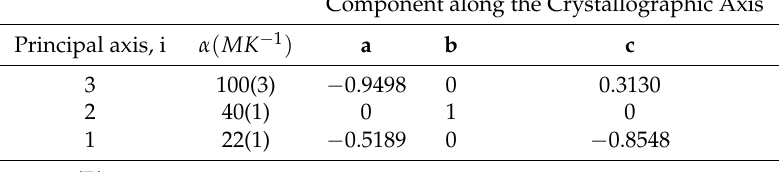
Table 2. The temperature (A) and pressure-induced strains: based on experimental data (B) and based on theoretical predictions (C). The α and K indicate accordingly the temperature- or pressure induced strain values along the principal axes, a, b and c indicate crystallographic directions. ( A ) Component along the Crystallographic Axis Principal axis, i α ( MK − 1